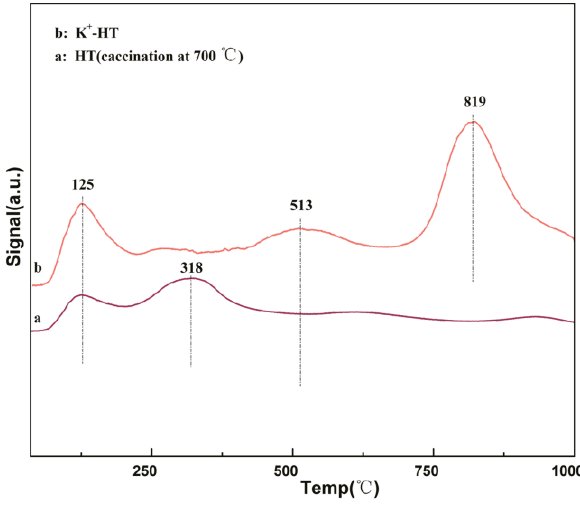
Figure 5. CO 2 -TPD curves of K + /HT and calcined MgAl-HT.